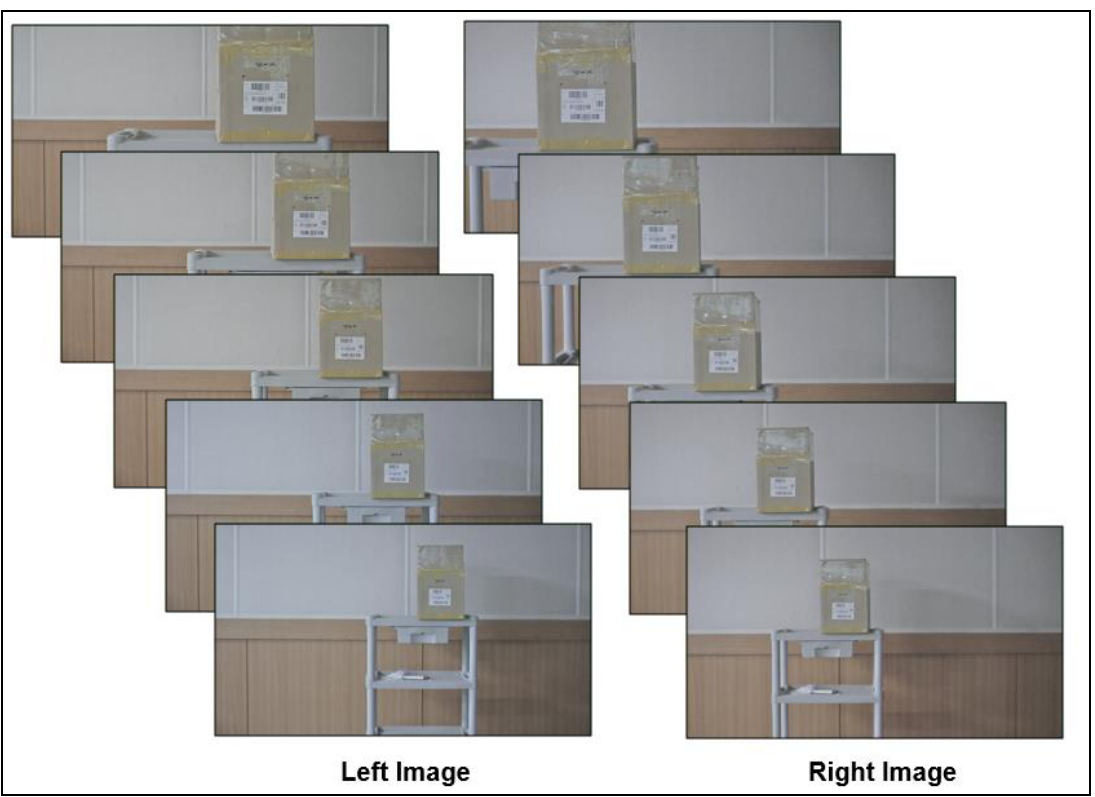
Figure 22. Images of left and right cameras acquired for distance verification.